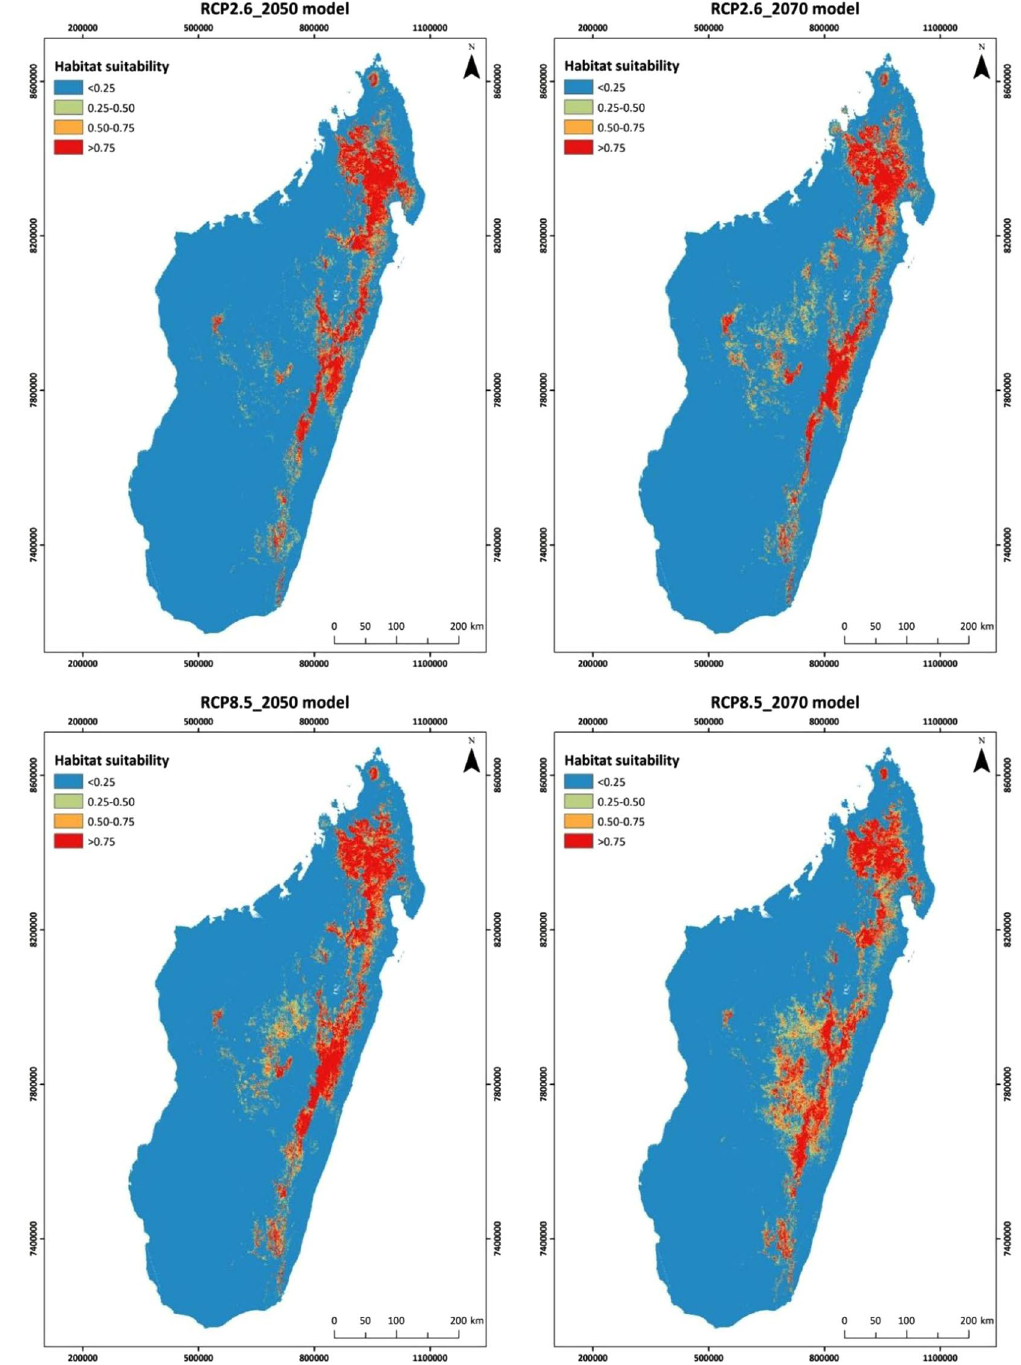
Figure 6. Predicted habitat suitability according to future climate scenarios (RCP2.6 above and RCP8.5 below) for 2050 (left) and 2070 (right) for Eleonora’s falcon at its main wintering area, Madagascar, based on satellite telemetry data of 17 adult falcons. Map was created with ArcGIS v10.1